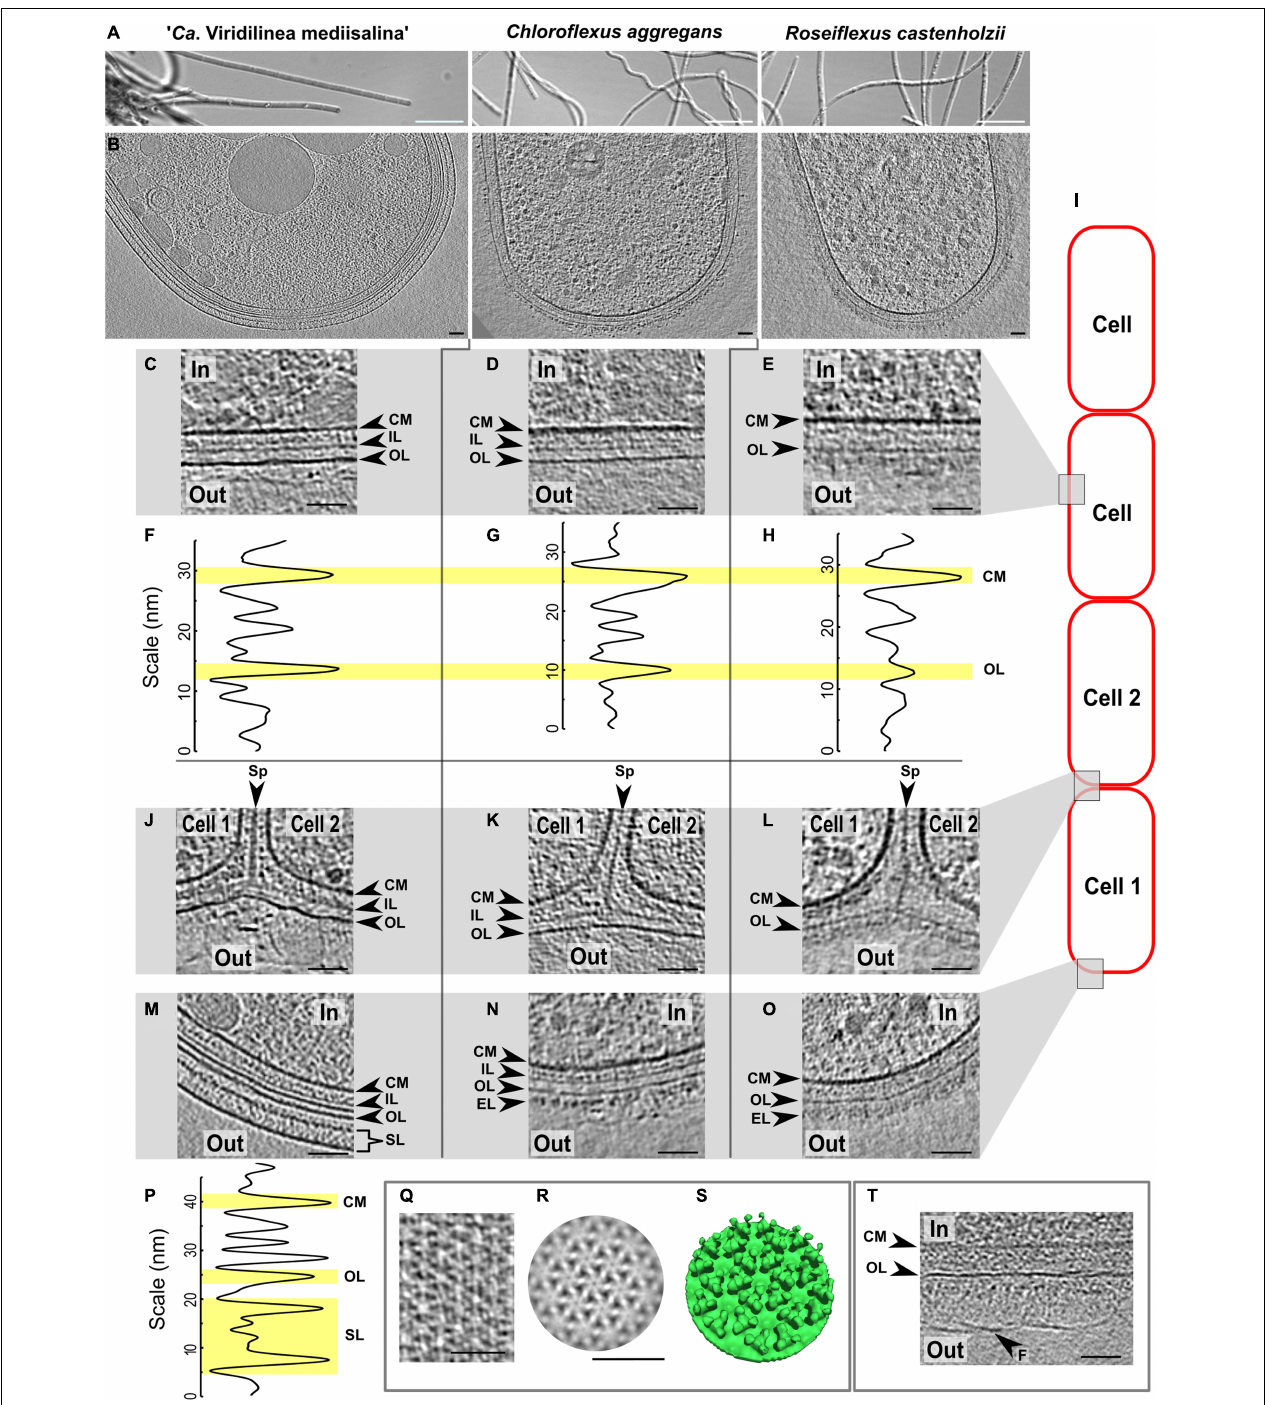
FIGURE 1 | Comparative cryo-ET of the cell envelope of the Chloroflexales bacteria. Morphology of the strains in a light microscope (A) . Slices through tomograms of a terminal cell in the multicellular filaments (B) . Slices through tomograms of a middle part of the cells in “ Ca . Viridilinea mediisalina” (C) , C. aggregans (D) , R. castenholzii (E) . Density profile of the cell envelope on the middle part of the cells in “ Ca . Viridilinea mediisalina” (F) , C. aggregans (G) , R. castenholzii (H) . Slices through tomograms of a cell-cell junctions in “ Ca . Viridilinea mediisalina” (J) , C. aggregans (K) , R. castenholzii (L) . Slices through tomograms of an apex of the terminal cells in “ Ca . Viridilinea mediisalina” (M) , C. aggregans (N) , R. castenholzii (O) . Density profile of the cell envelope in the apex of the “ Ca . Viridilinea mediisalina” terminal cell (P) . S-layer on tomogram without cryo-FIB (Q) . Sub-tomogram averaging of the S-layer (R) and its isosurface (S) . Fibrillar layer on a middle part of the cells in “ Ca . Viridilinea mediisalina” (T) . In, cytoplasm in a cell; out, extracellular space; CM, cytoplasmic membrane; EL, external layer; FL, fibrillar layer; F, fibrils; IL, intermediate layer; OL, outer layer; SL, S-layer; Sp, septum. Bars: 10 µ m (A) , 50 nm (B–T) . Scheme of the bacterial multicellular filament (I) .